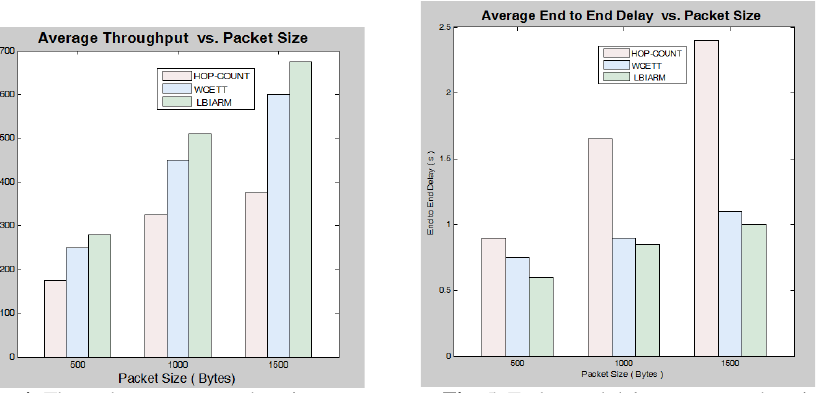
Fig. 4. Throughput versus packet size. Fig. 5. End to end delay versus packet